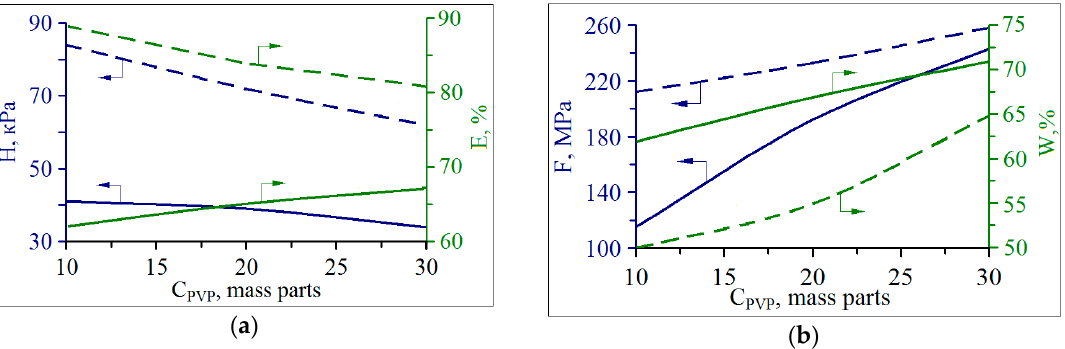
Figure 8. Effect of polyvinylpyrrolidone (PVP) content in a polymer–monomer composition (PMC) on the properties of Ni/ р HEMA-gr-PVP composites, obtained at pH 4 (–––) and at pH 8 (-----) in swollen ( а ) and dry ( b ) states ([NiSO 4 ] = 0.55 mol/L).